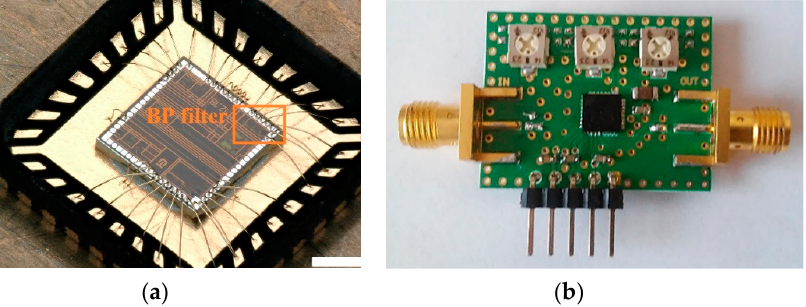
Figure 11. Bandpass filter ASIC prototype: ( a ) packaged die; ( b ) test printed circuit boards (PCB).